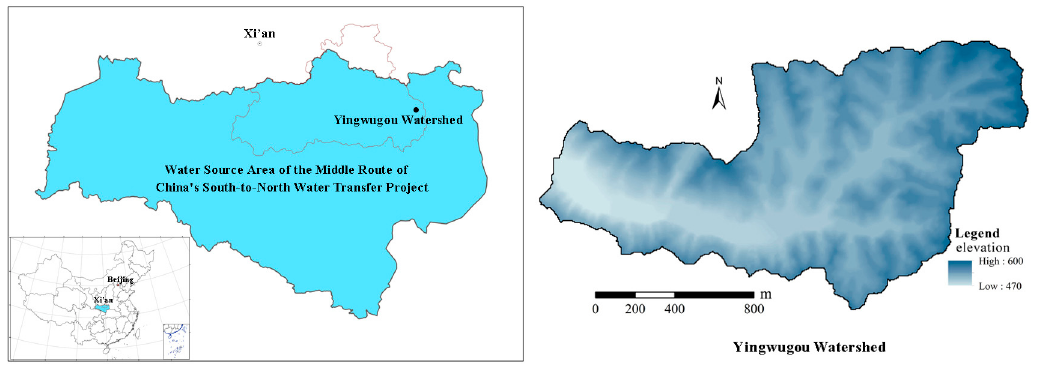
Figure 1. Location of the study area.